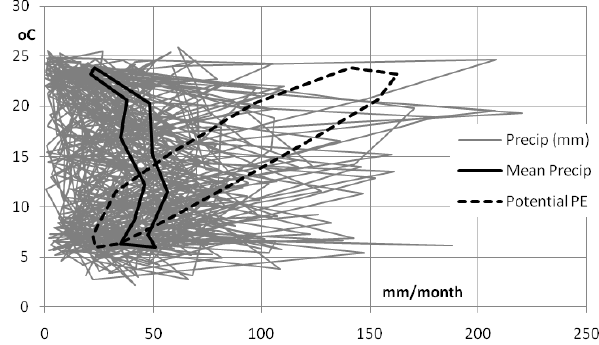
Fig. 1. Example of 50-yr synthetic climate realisation for the Celone catchment, near